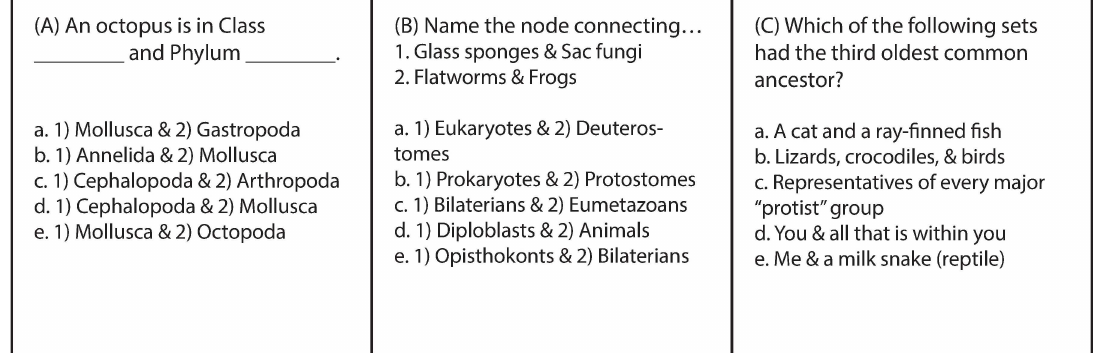
Fig 3. Three typical test questions reflect student expectations in introductory Evolution and Biodiversity. (A) Shows a typical question from a course that teaches rank-basedclassification, whereas(B) and (C) requiresthat students understand higher-order principles beyond memorization after learninga phylogenetic classification of diversity. (Answers: d., e., a.)